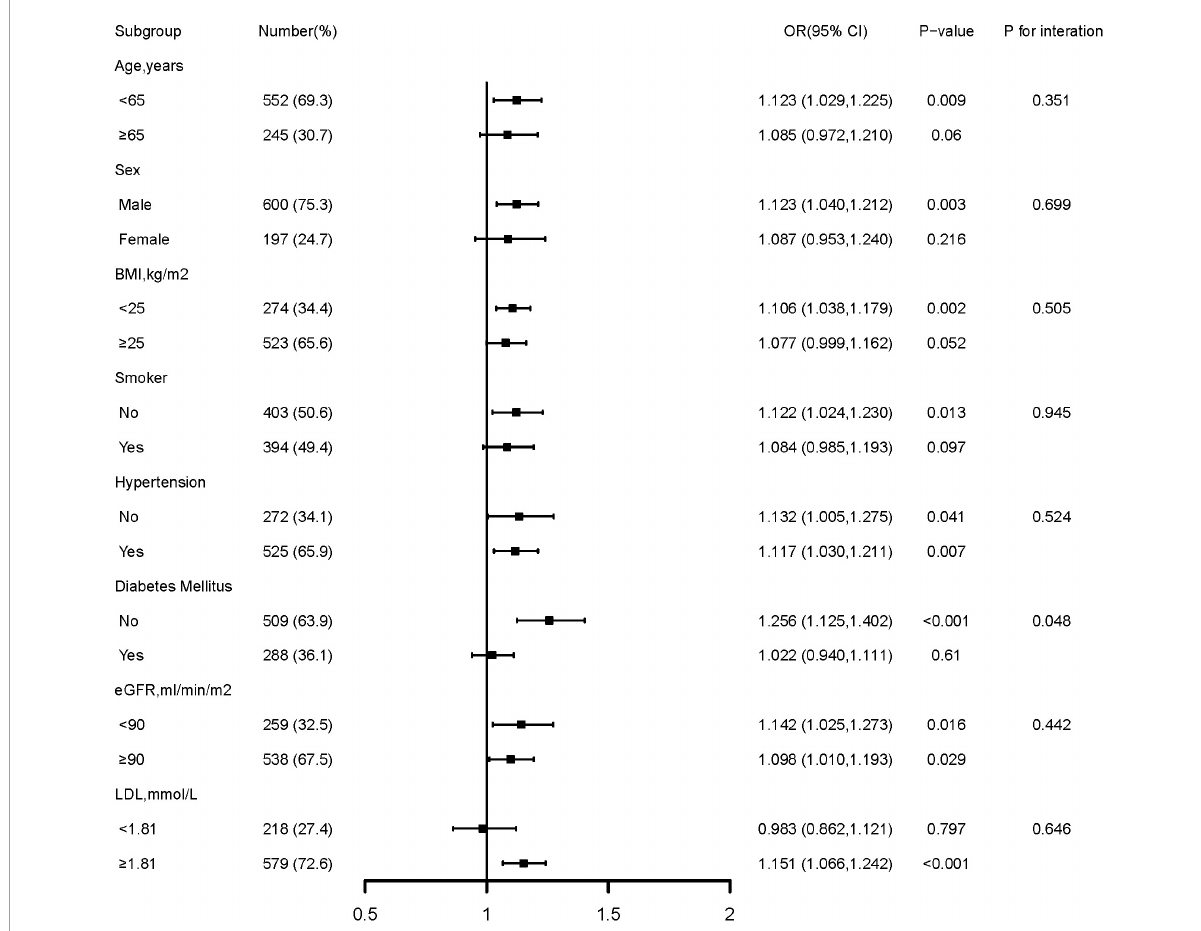
FIGURE3 Forest plot investigating the association between GA and the prevalence of DES-ISR in different subgroups. DES, drug-eluting stent; ISR, in-stent restenosis; BMI, body mass index; eGFR, estimated glomerular filtration rate; LDL-C, low-density lipoprotein cholesterol; LVEF, left ventricular ejection fraction; OR, odds ratio; CI, confidence interval.